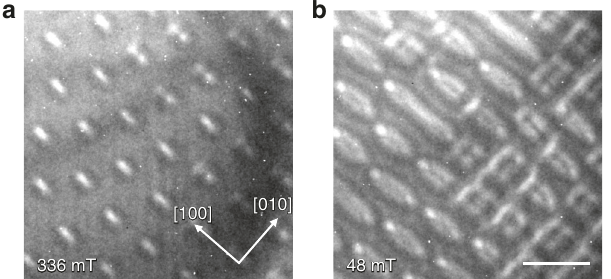
Fig. 6 Coexistence of antiskyrmions and elliptical skyrmions. Near a transition temperature of 268 K, we fi nd both topologically distinct nano- objects simultaneously. a shows the results at 336 mT and b at 48 mT. In agreement with the measurements at 300 K (Fig. 1), we observe round antiskyrmions at elevated magnetic fi eld strengths (336 mT) and square antiskyrmions at low fi elds (48 mT). At both fi eld strengths elliptical skyrmions are present, whose size increases when the fi eld is decreased. The scale bar corresponds to 300